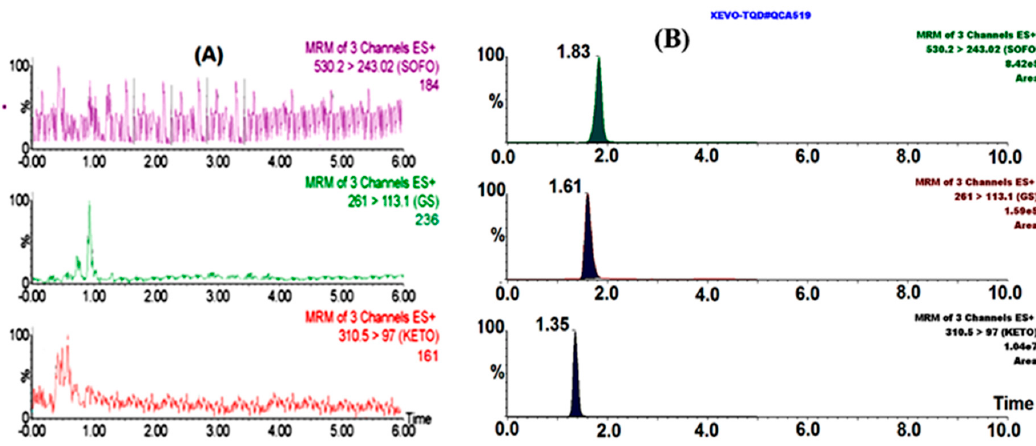
Figure 4. Chromatogram of ( A ) drug-free human plasma, ( B ) spiked plasma with sofosbuvir, GC331007 and ketotifen (IS) from top to bottom.